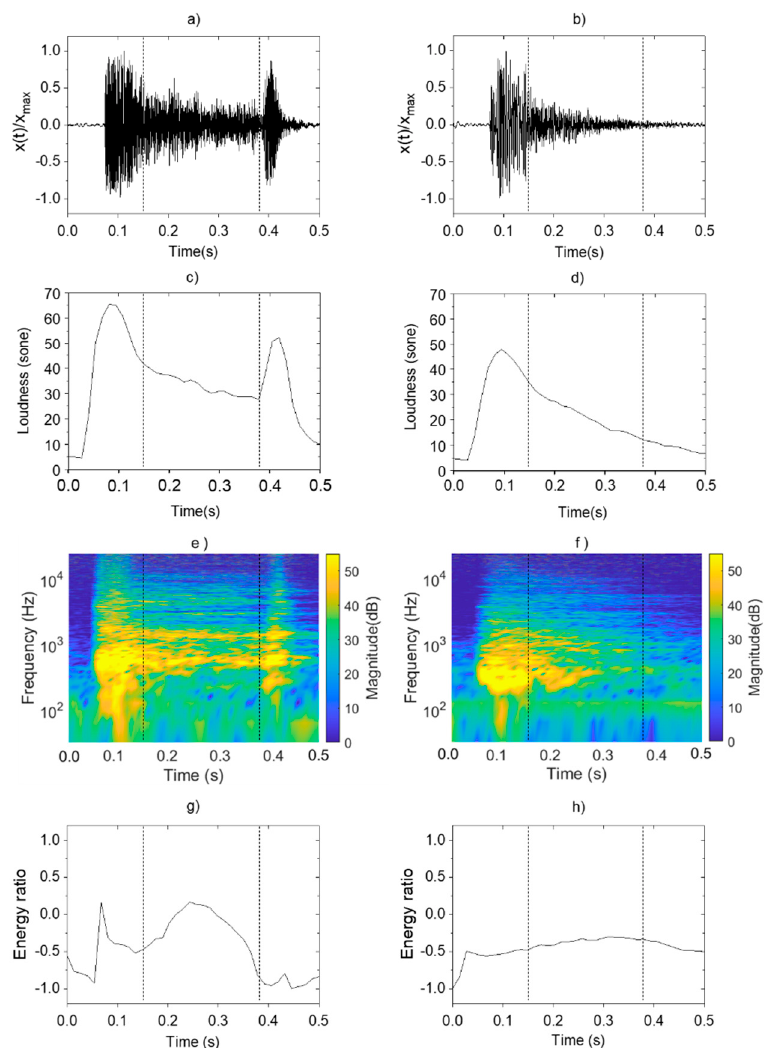
Figure 2. Analysis and comparison of acoustic characteristics of pneumonia and non-pneumonia cough sounds: sound pressure level of ( a ) pneumonia; ( b ) non-pneumonia; loudness of ( c ) pneumo- nia; ( d ) non-pneumonia; STFT of ( e ) pneumonia; ( f ) non-pneumonia; energy ratio of ( g ) pneumonia; ( h ) non ‐ pneumonia.